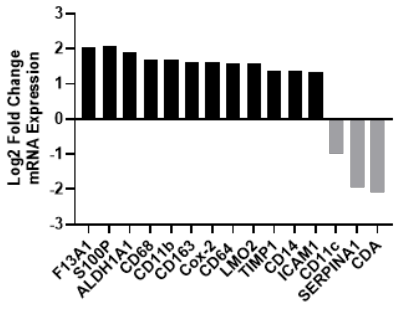
Figure 4. Fold-Change Gene Expression of Suppressive Monocyte Associated Genes in HPV+R+ versus HPV+R- patients. HPV+R+ patients demonstrated a higher fold-change expression for the genes associated with poor differentiation of monocytes: (F13A1, ALDH1A1); M2 polarization phenotype (PTGS2, CD68, CD163); and decreased expression of M1 macrophage-associated genes (CD11c and